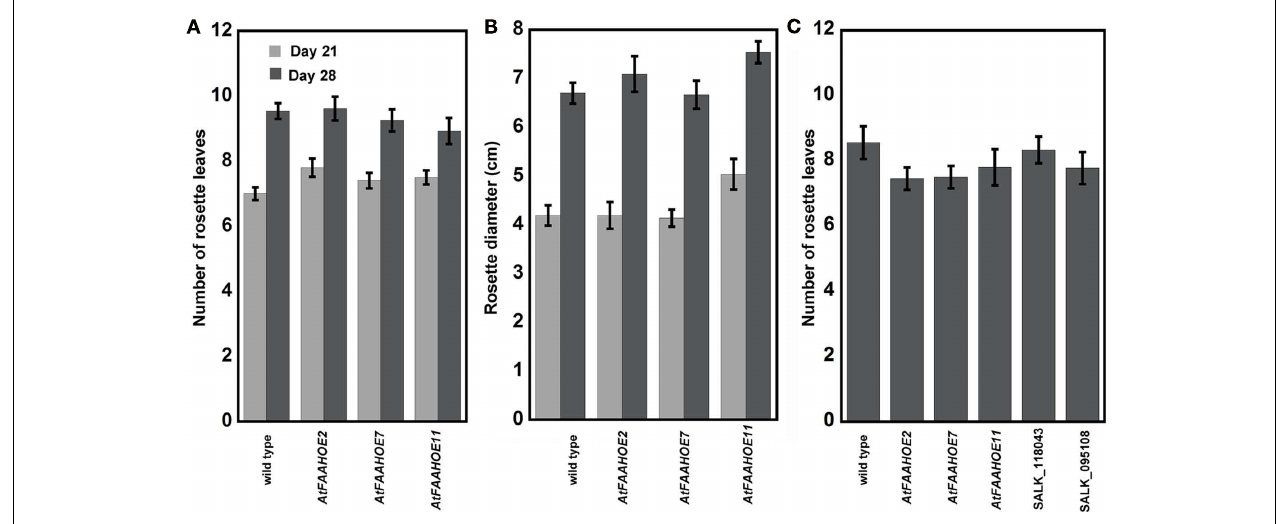
FIGURE 2 |The number of rosette leaves and rosette diameter is not affected by altered AtFAAH expression. Number of rosette leaves (A) and rosette diameter (B) of wild type and three AtFAAH overexpressors under SDs after 21days, when no plants were flowering, and after 28days, when